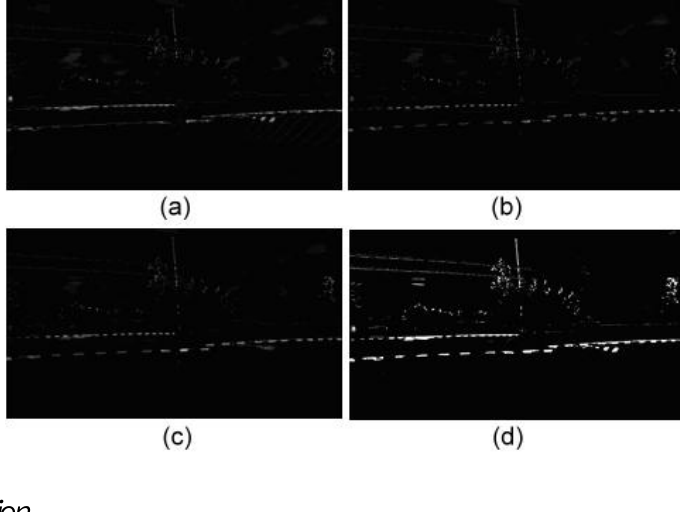
Figure 6. Background subtraction results in RGB planes: ( a ) the result of the background subtraction in the R plane; ( b ) the result of the background subtraction in the G plane; ( c ) the result of the background subtraction in the B plane; ( d ) the result after the summation and binarization of Figure